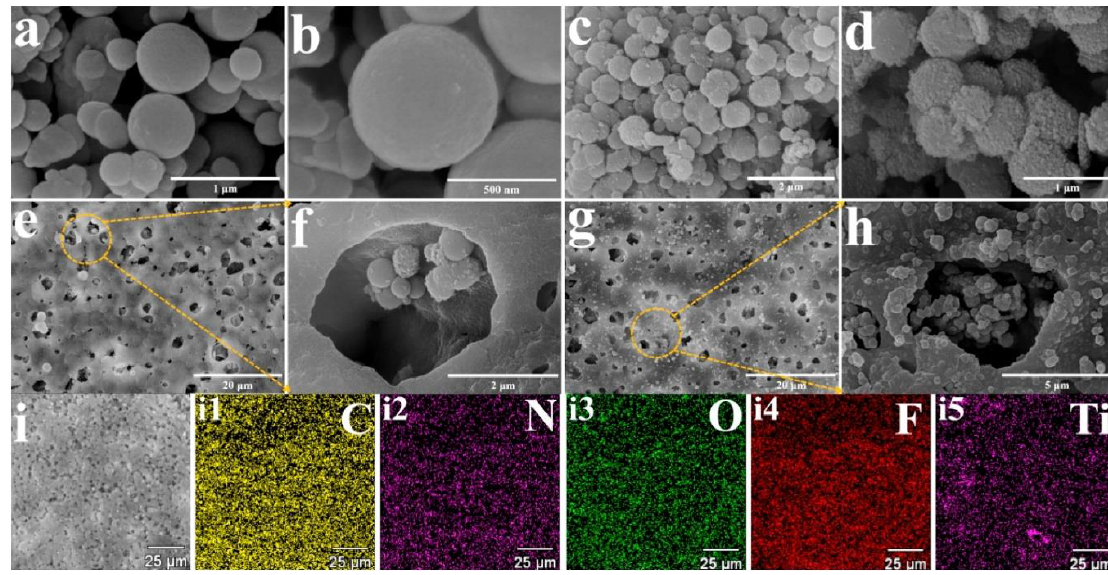
Figure 3. Scanning electron micrographs ( a – i ) and elemental mapping ( i1 – i5 ) for carbon, nitrogen, oxygen, fluor, and titanium) of imprinted nanocomposite based on TiO 2 core and polydopamine shell. Adapted with permission from Reference [81]. Elsevier, 2020.